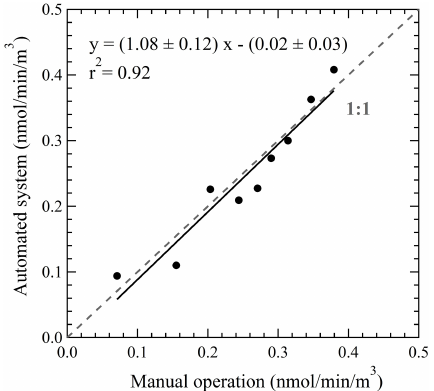
Figure 5. Comparison of the automated system with manual opera- tion using ambient aerosol extracts (PM 2 . 5 samples collected from JST site, Atlanta, in December 2012) (regression analysis was done by orthogonal regression; the dotted line is